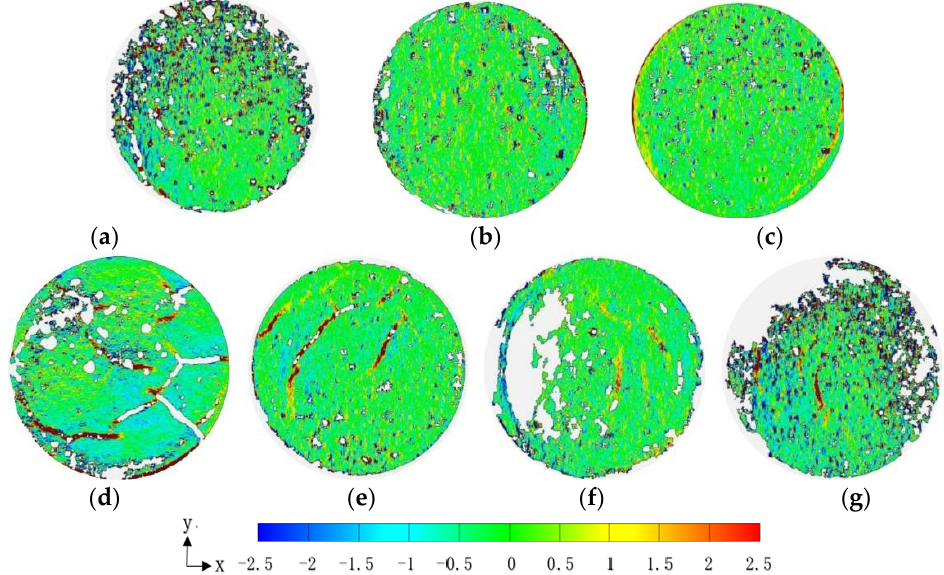
Figure 7. Strain field along the X-direction of the specimens at 70 min: ( a ) ε x -PC; ( b ) ε x -H0.25; ( c ) ε x -P0.25; ( d ) ε x -H0.5; ( e ) ε x -P0.5; ( f ) ε x -H1; ( g ) ε x -P1. A horizontal line through the center point of the specimens may be drawn to repre- sent the positions of interest, as shown in Figure 8. The strain values in the X-direction of the horizontal axis of the specimen’s center , changing with their position along the drawn